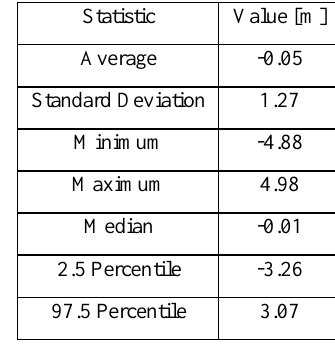
Table 2. Relative Comparison Results